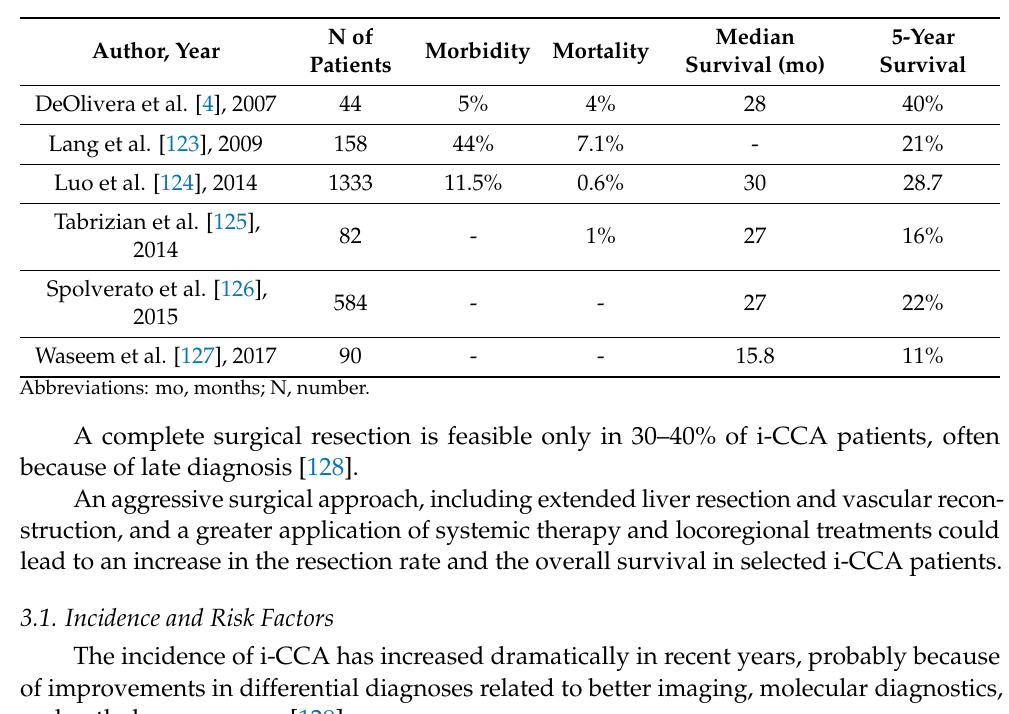
Table 4. Intrahepatic cholangiocarcinoma, post-operative